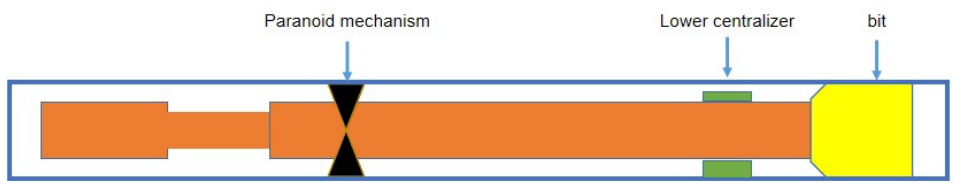
Figure 1. Schematic diagram of the new rotary steerable drilling system.